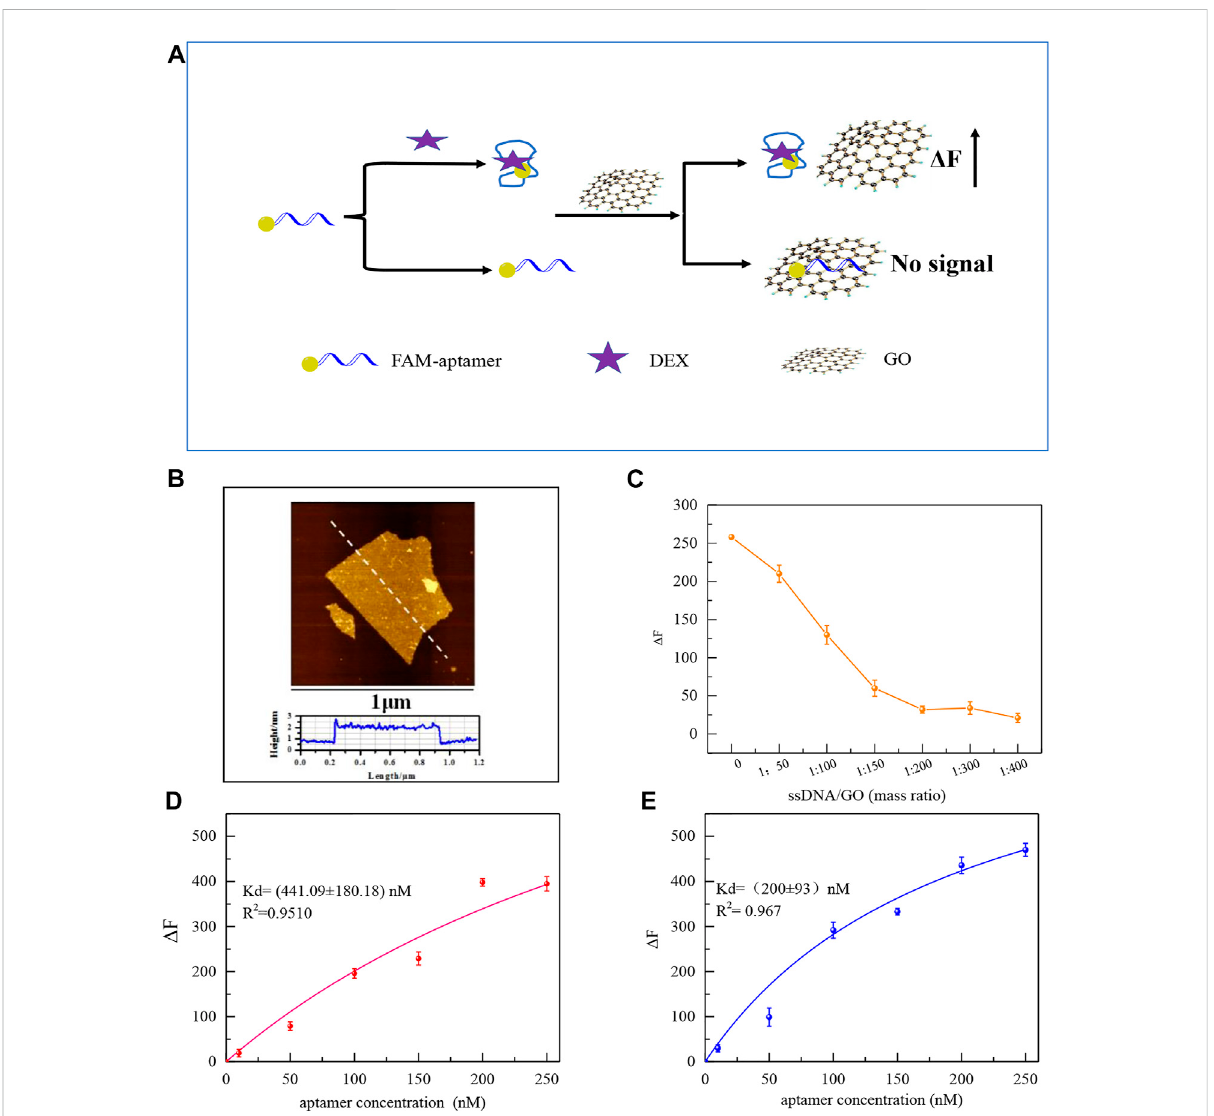
FIGURE 5 Schematic diagram of the principle of af fi nity fl uorescence detection of GO-based aptamers for DEX (A) . The AFM images of GO (B) . Effect of GO addition concentration on Δ F (C) . Saturation curves of original aptamers for DEX by GO fl uorescence method (100 μ L original aptamer +100 μ L 1.5 μ M DEX+ the mass ratio of GO to aptamer is 200:1 (D) , and saturation curves of mutant aptamers (100 μ L aptamer Apt-M13 + 100 μ L 1.5 μ M DEX+ the mass ratio of GO to aptamer is 200:1) (E) .